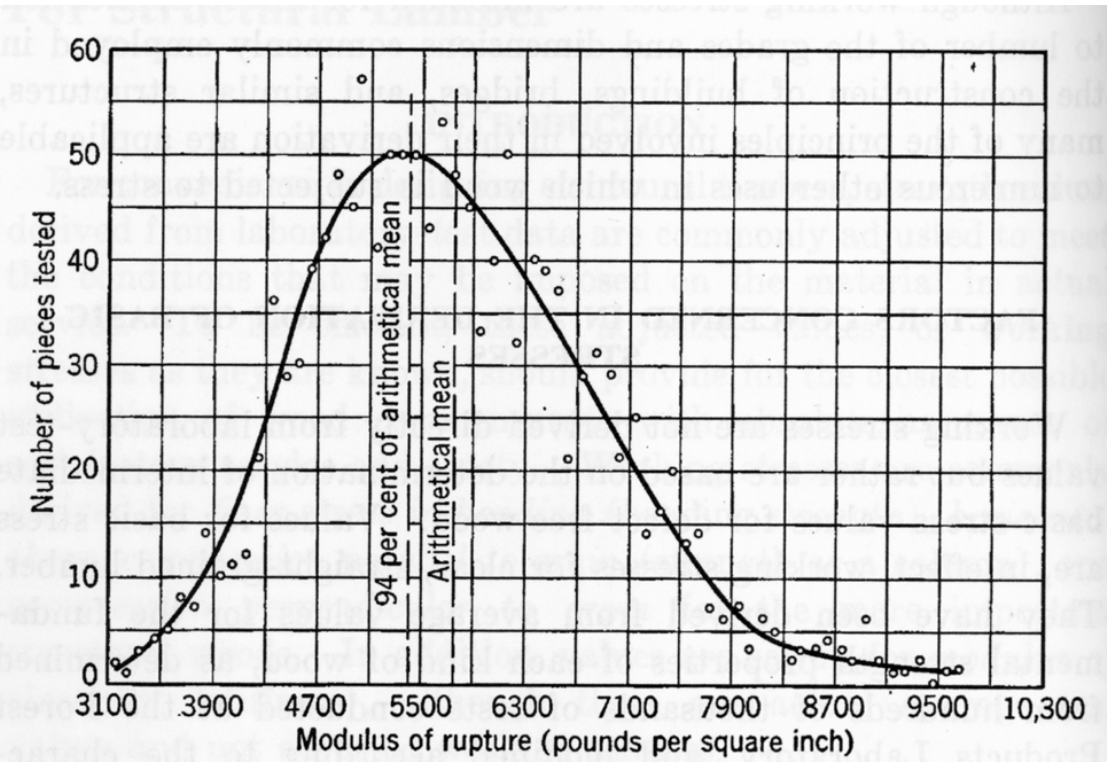
Figure 19. Variability in the modulus of rupture (MOR) of unseasoned clear-wood Sitka Spruce ( Picea sitchensis ). From [112]. White circles are data points.